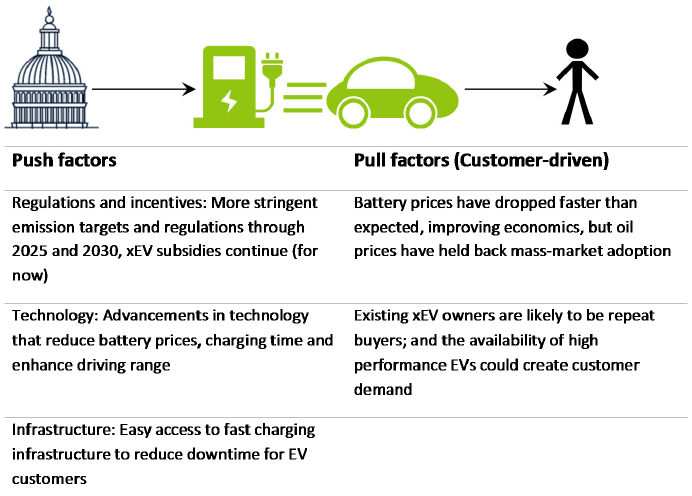
Figure 4. Factors that determine electric vehicle (EV) adoption [9].